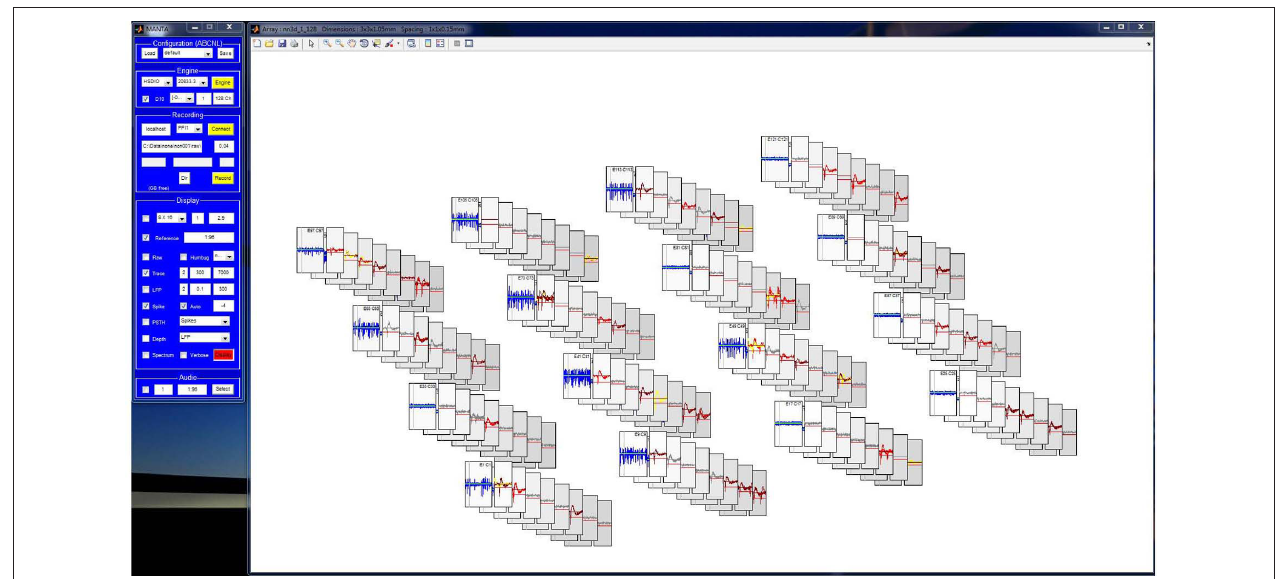
axes indicates the distance of plot from the view plane. This plot also illustrates MANTA’s simulation mode, which allows for offline development, i.e., spikes, line noise, slow noise, and background noise are simulated for testing filtering and display